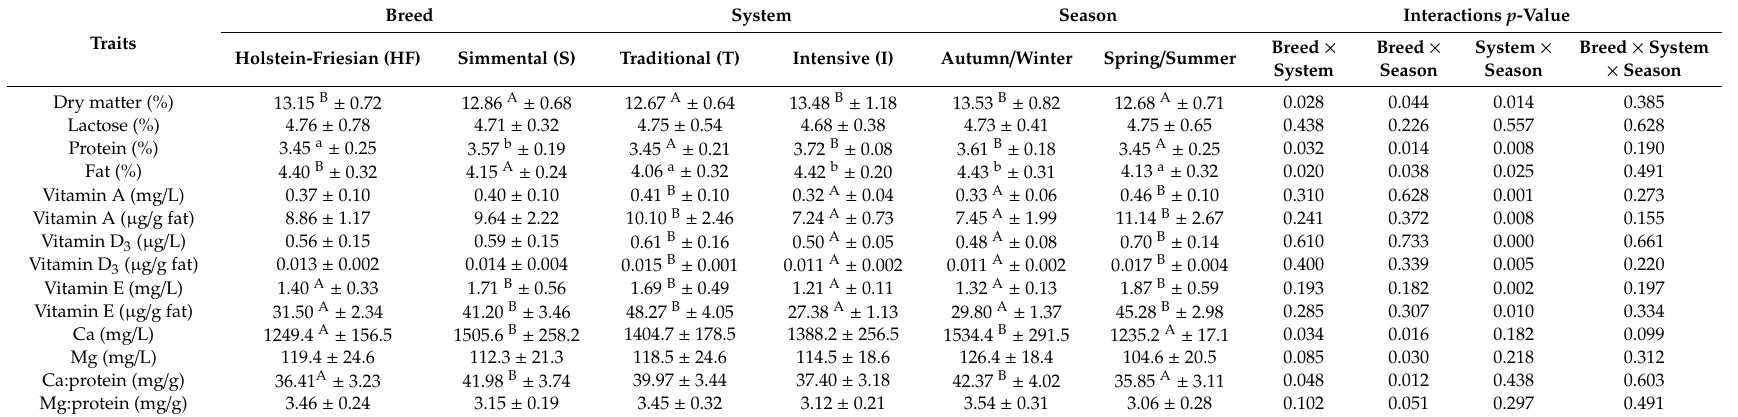
Table 1. Content of basic chemical components, selected fat-soluble vitamins, and macro-elements in bulk milk, depending on the experimental factors ( x ± SD).